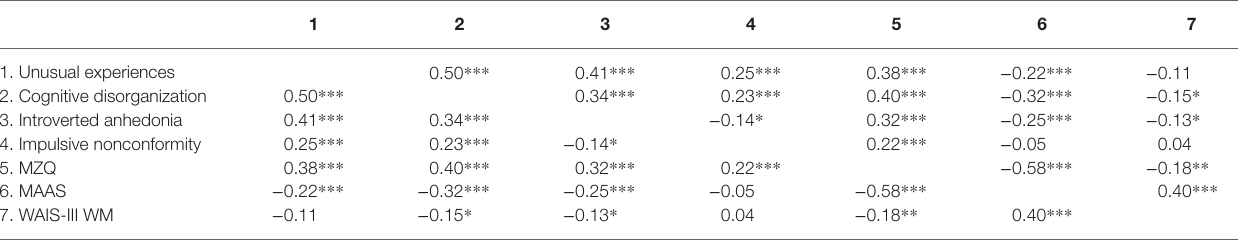
TABLE 2 | Correlations between schizotypal traits, mindfulness, mentalization, and WM ( N =